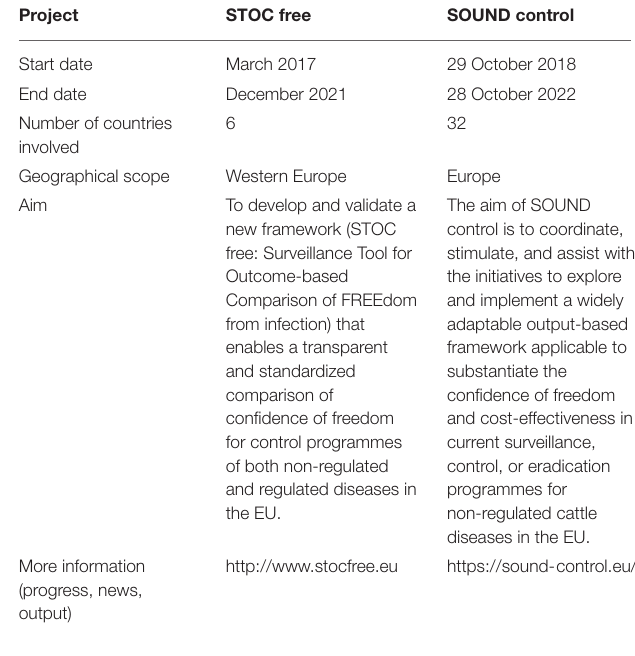
TABLE 1 | Overview of the STOC free and SOUND control project.